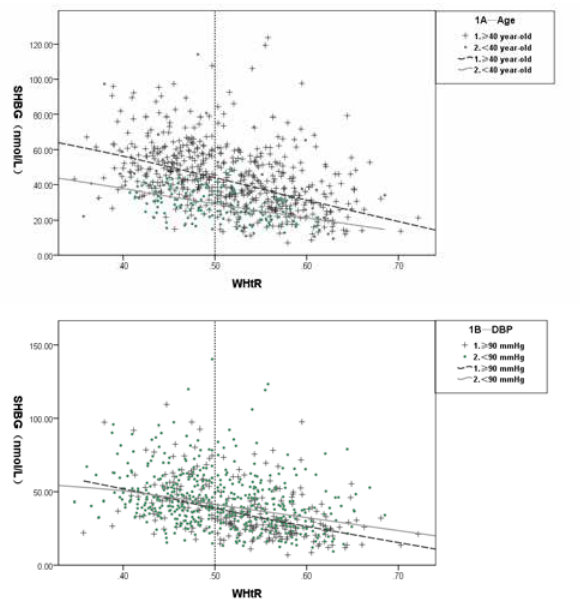
Figure 1: Relation between WHtR and SHBG level by physiologic characteristics (A) age and (B) DBP. The 0.50 cutoff of WHtR is shown by the upright dotted